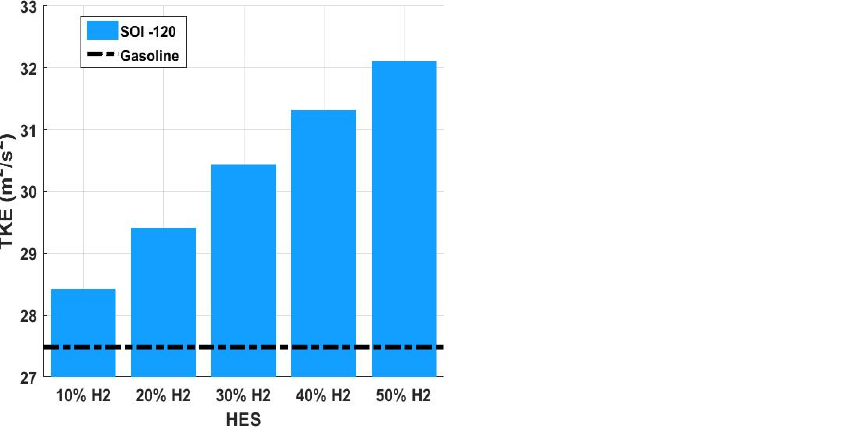
Figure 4. Effects of HES on turbulent kinetic energy (TKE) for SOI − 120 CA aTDC.